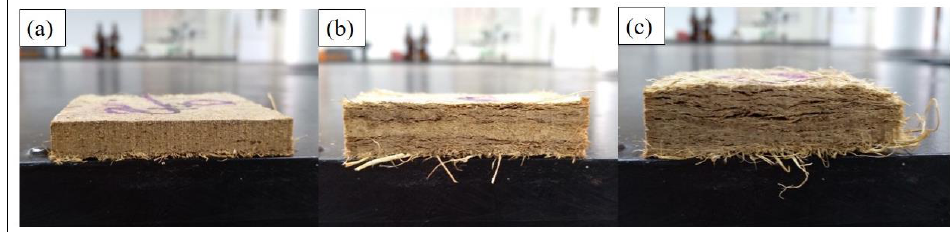
Figure 13. Examples of specimens after water absorption test. ( a ) Composite panel made from 100 SMS: 0 EFB, ( b ) sandwich composite panel made from 60 SMS: 40 EFB, and ( c ) composite panel made from 0 SMS: 100